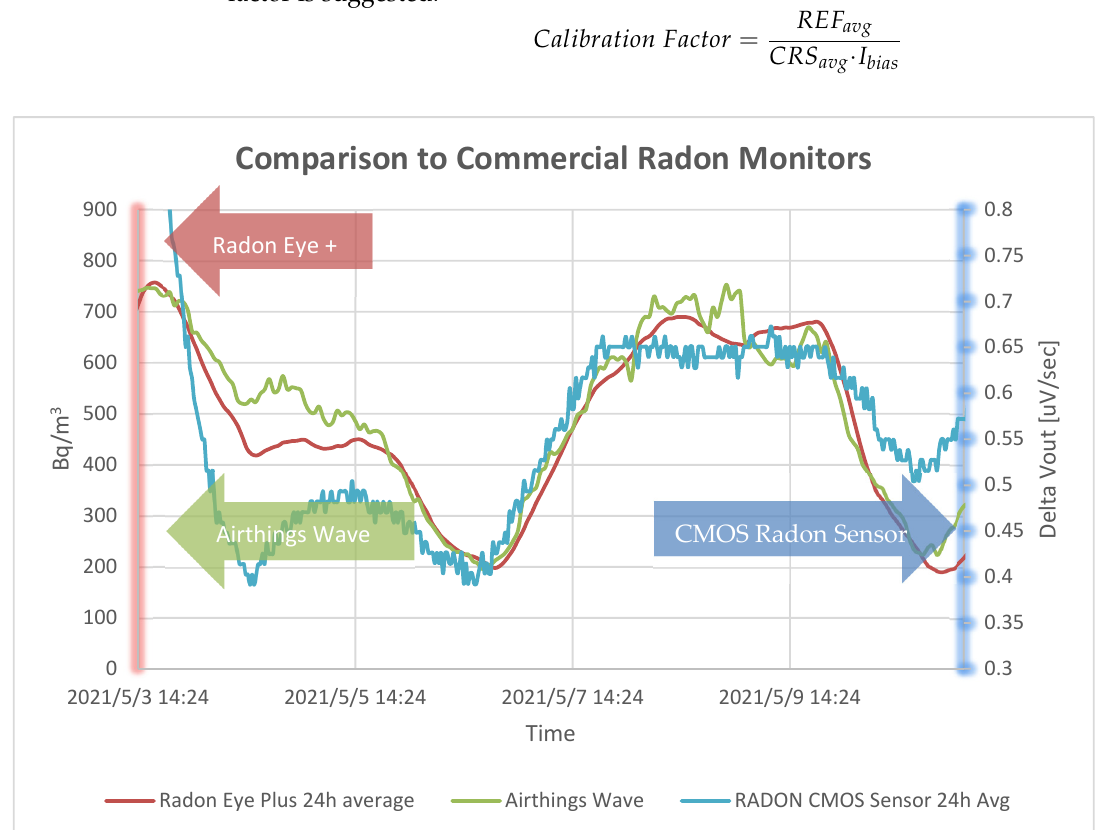
Figure 12. CMOS Sensor comparison to commercial detectors [17,18].